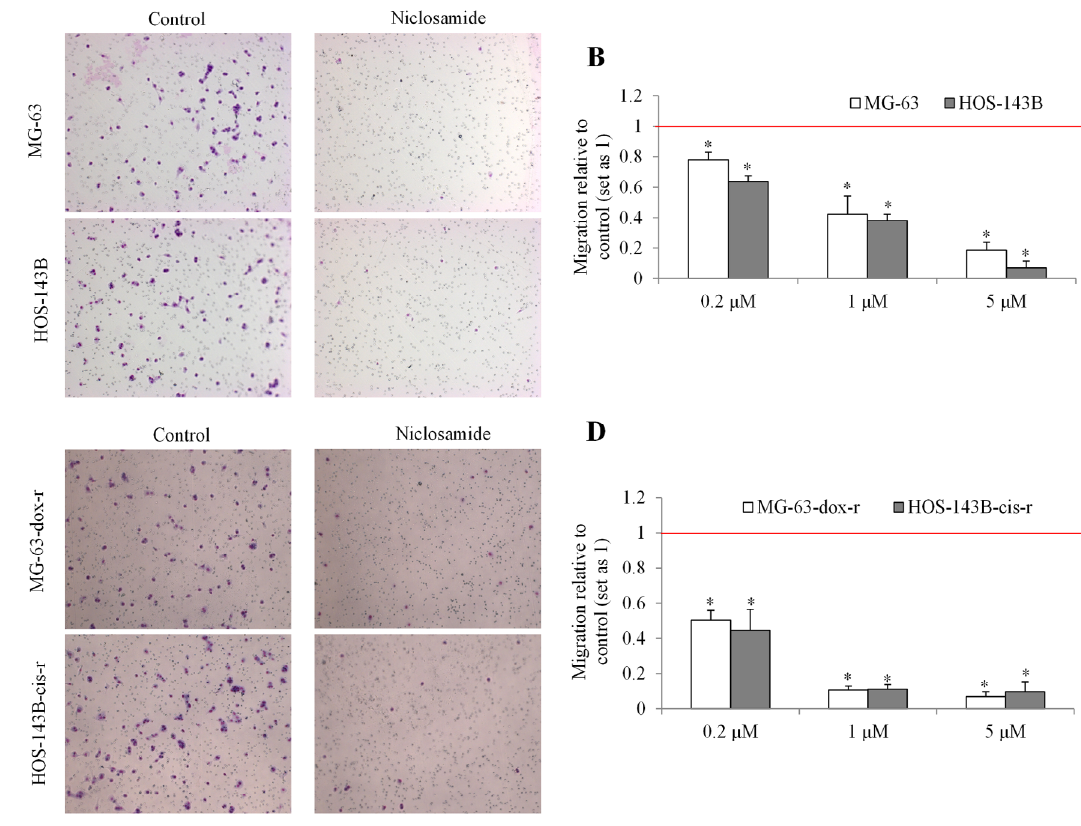
Figure 4 – Niclosamide decreases migration in parental and chemo-resistant osteosarcoma cells. (A and C) Representative images of migration of MG-63, HOS-143B, MG-63-dox-r and HOS-143B-cis-r cells in the absence (control) and presence of niclosamide (5 µM). (B and D) Quantification of osteosarcoma cell migration exposed to different concentrations of niclosamide. *, p<0.5, compared to control. Control was set up as 1. Unpaired Student’s t test was